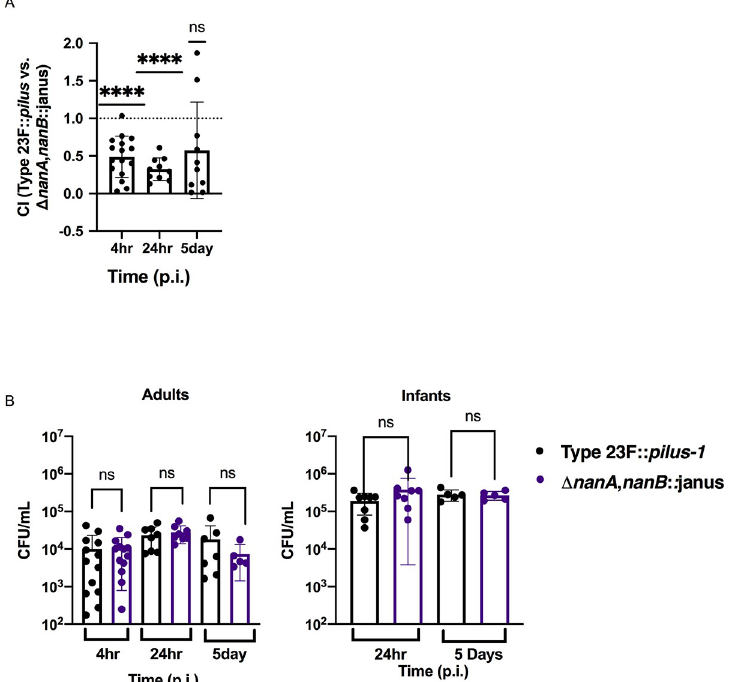
Fig 6. Effect of neuraminidases on colonization in vivo . (A) Adult mice were intranasally infected with a suspension containing equal amounts of Type 23F:: pilus-1 and isogenic double neuraminidase mutant. Colonization density was assessed 4h, 24h and 5 days p.i. in the URT lavages to calculate the competitive index (CI ). Dotted line represents CI = 1. Group medians were compared to a CI = 1 by one sample T and Wilcoxon signed rank test and resulting p- values are indicated ���� , p < 0.0001. (B) Adult (left panel) and infant (right panel) mice were intranasally infected with Type 23F:: pilus-1 or Δ nanA , nanB ::janus. Colonization density was assessed at 4h, 24h and 5 days p.i. in adult mice and 24h and 5 days p.i. in infant mice. Experiments were repeated twice and groups represent n = 5–15 animals. Error bars correspond to S.D. by Mann-Whitney test.